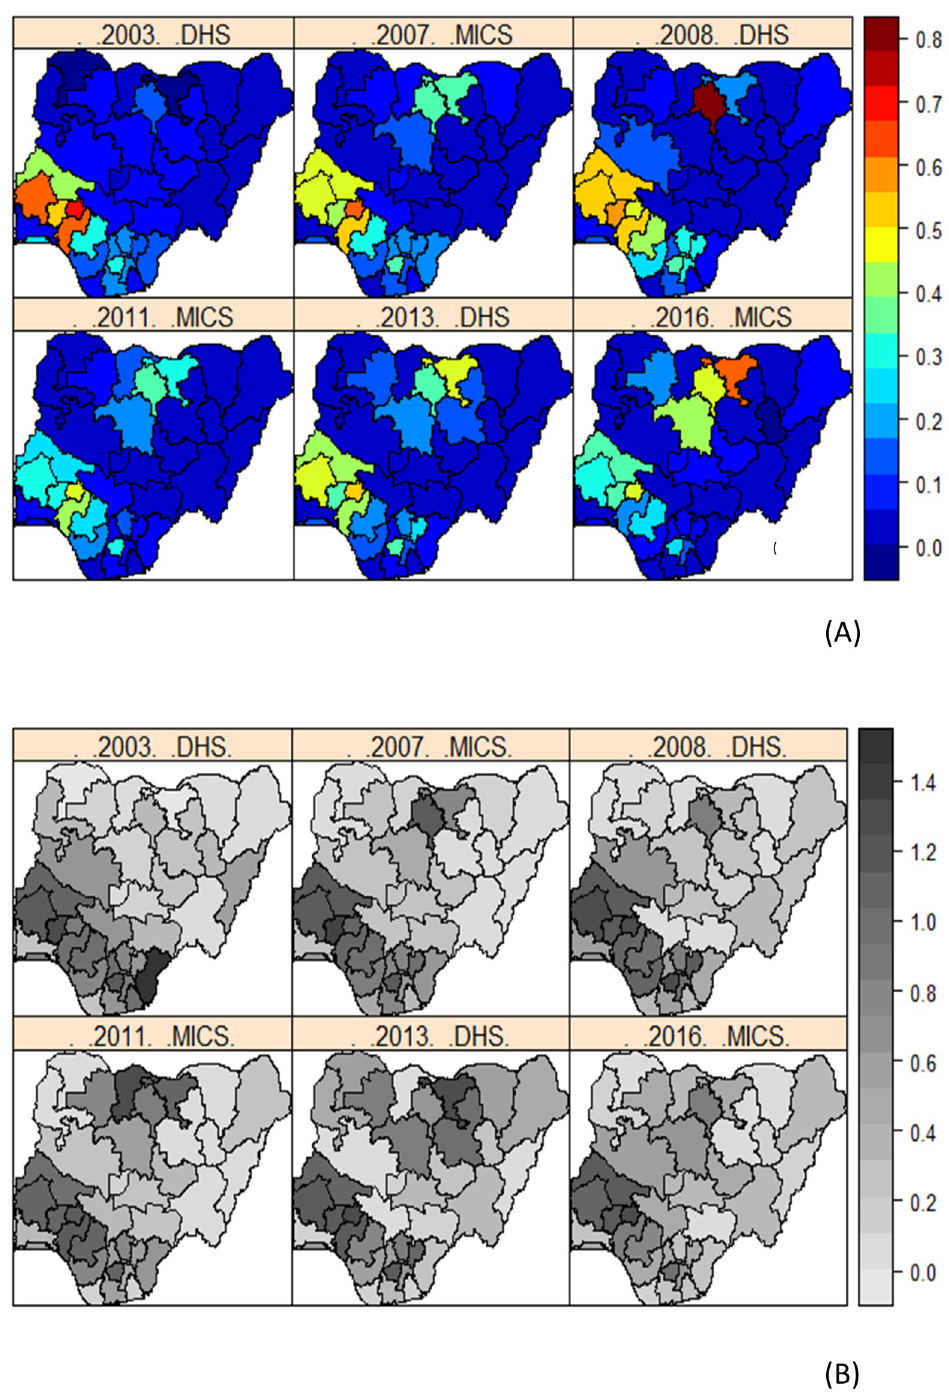
Fig 8. Posterior estimates. (A) Predicted prevalence of FGM/C among 0-14-year old girls in Nigeria from 2003 to 2016 based on m 6 . (B) Corresponding deviance maps for the estimates. Dark blue to dark red implies lowest to highest prevalence. Shapefile republished from DIVA-GIS database (https://www.diva-gis.org/) under a CC BY license, with permission from Global Administrative Areas (GADM), original copyright 2018.